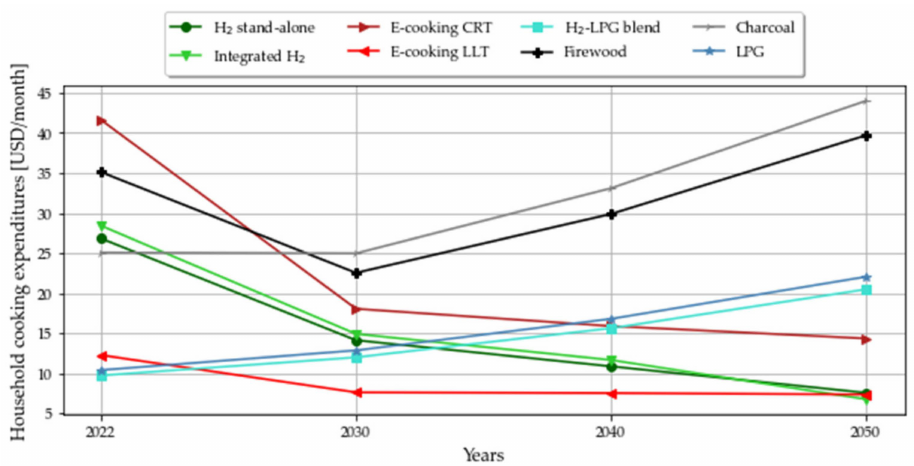
Figure A5. Household cooking expenditure evolution from 2030 to